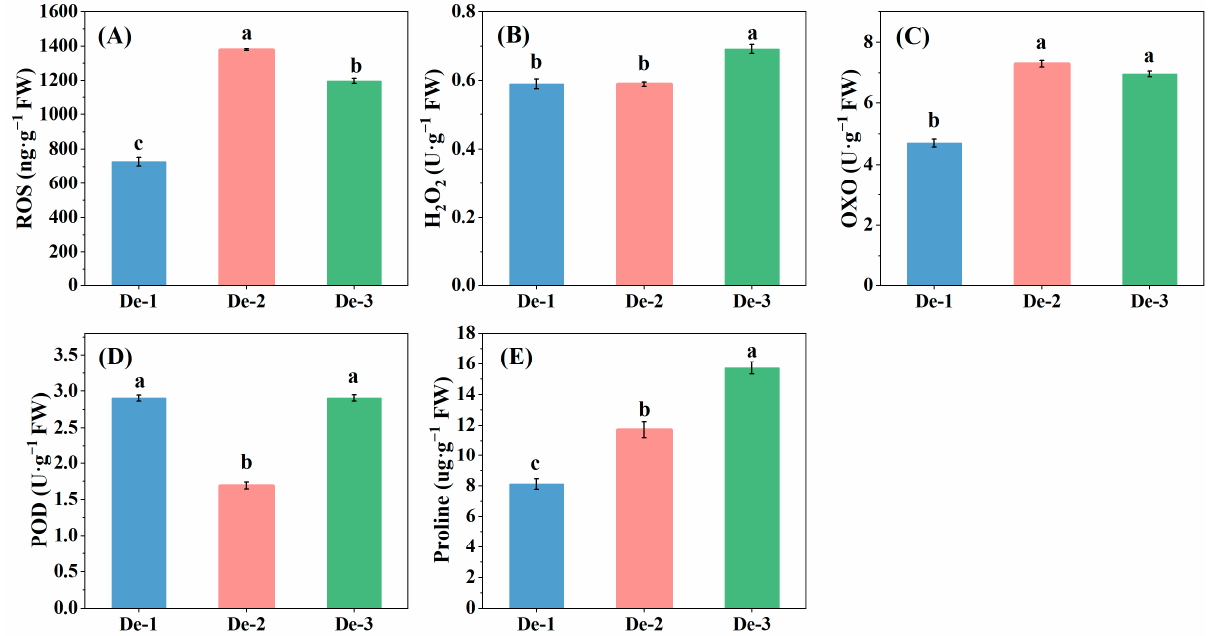
Figure 7. The contents of ( A ) reactive oxygen species (ROS), ( B ) hydrogen peroxide (H 2 O 2 ), ( C ) oxalate oxidase (OXO), ( D ) peroxidase (POD), and ( E ) proline in kale root grown under different nutrient-solution depths. Different letters (a–c) marked upon the columns in the figure indicate significant differences between treatments by Duncan’s multiple ( p < 0.05), and vertical bars represent the standard margin of